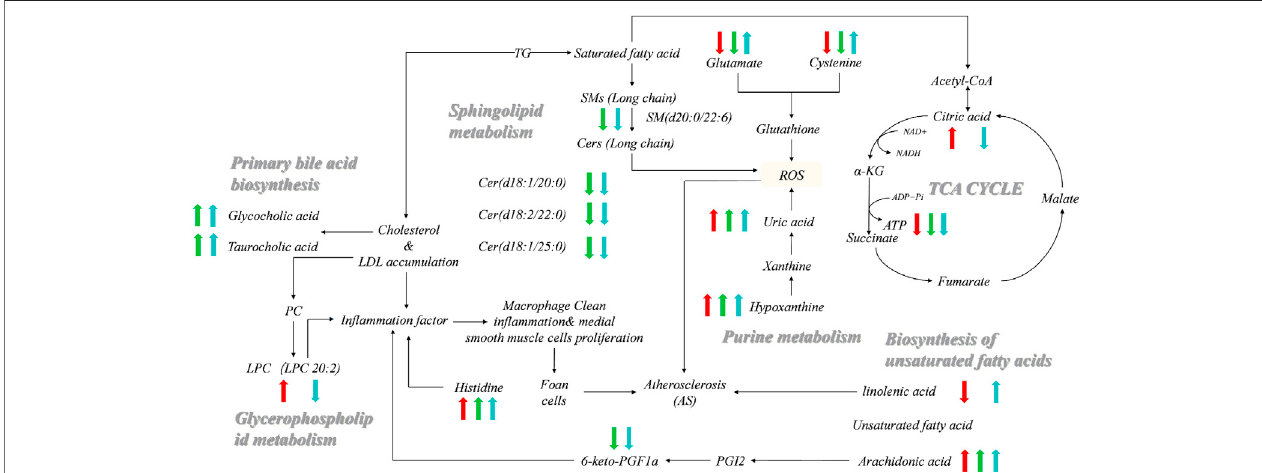
FIGURE 6 | Networks of potential serum biomarkers of CHD that varied among the healthy control, Shi-subtype, and Xu-subtype groups. Arrows ( “ ↑↓ ” ) indicated the signi fi cantly upregulated ordownregulated metabolites inthe Shi(red) and Xu(green) patients comparedtothe healthy control, respectively. Thesigni fi cantchanges of metabolites in the Shi group compared to the Xu group are also indicated (blue). There are seven metabolites, i.e., Linolenic acid, Citric acid, Uric acid, Taurocholic acid,Hypoxanthine,Arachidonicacid,andGlycocholicacidcomingfromthedatasetofunbiasedanalysisusingUPLC-qTOF-MS,thenon-targetedmetabolomics study. There were eight metabolites, i.e., Histidine, Cysteine, Glutamine, LPC (20:2), Cer (d18:1/20:0), Cer (d18:1/22:0), Cer (d18:1/25:0), and SM (d22:0/22:6) coming from the data set of the targeted metabolomics study using QqQ-MS.